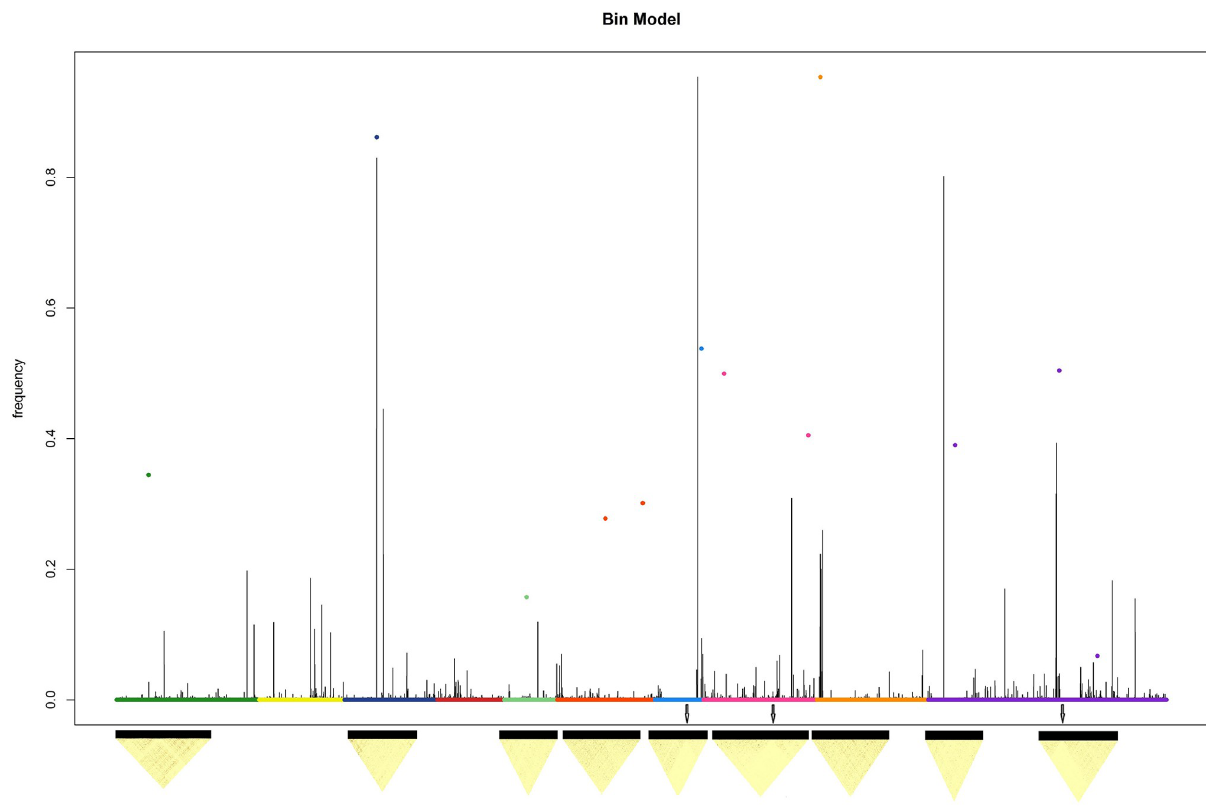
Fig 10. Weighted function describing the Genomic profile relates to 611 Eucalyptus plants simulated from the 36,812 SNPs obtained the real data. The dots represent the position e effects of simulated genes. The heat map represents the genomic LD around the simulated